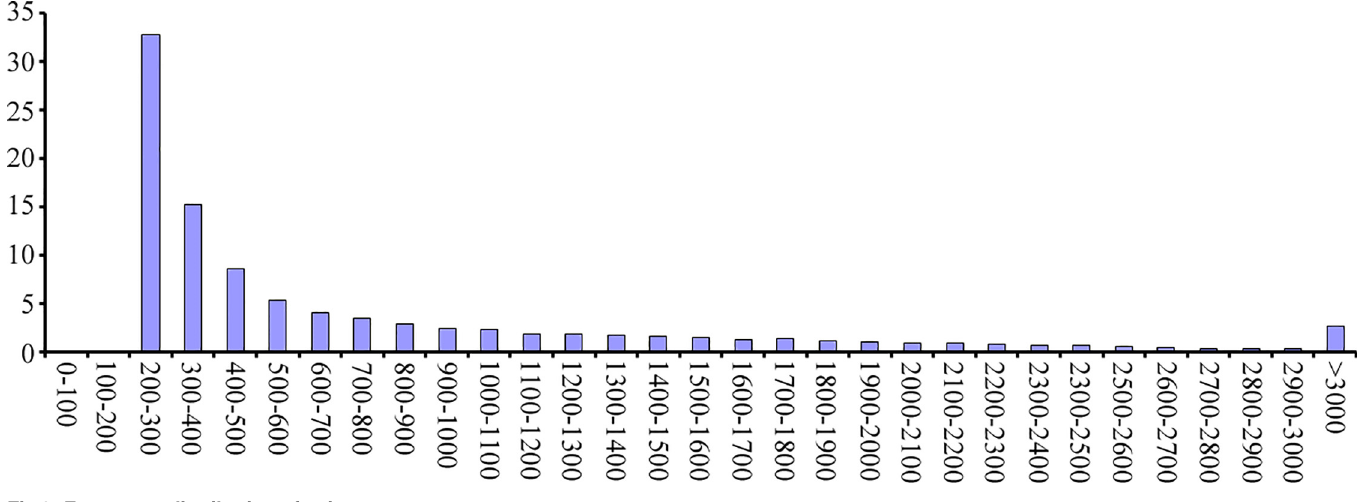
Fig 2. Frequency distribution of unigenes.